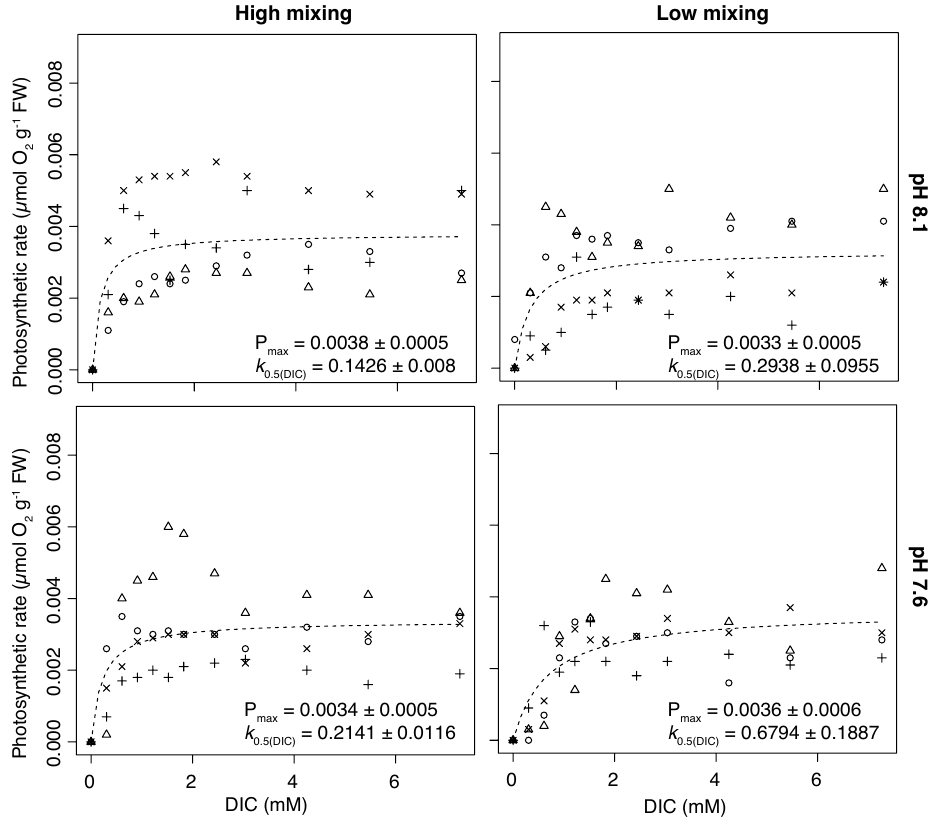
Figure 3. Photosynthetic rates (P) of Xiphophora gladiata (CCM) at increasing concentrations of DIC at high (left graphs) and low (right graphs) mixing treatments and at a pH of 8.1 (top graphs) and low pH of 7.6 (bottom graphs). Different shaped points represent the individual replicates (n = 4) with the dashed line indicating the P max ( [ DIC ] ) fitted Michaelis–Menten curve ( P = k 0.5 +[ DIC ] ). Values of P max and k 0.5(DIC) listed on the figure are means ± SE.